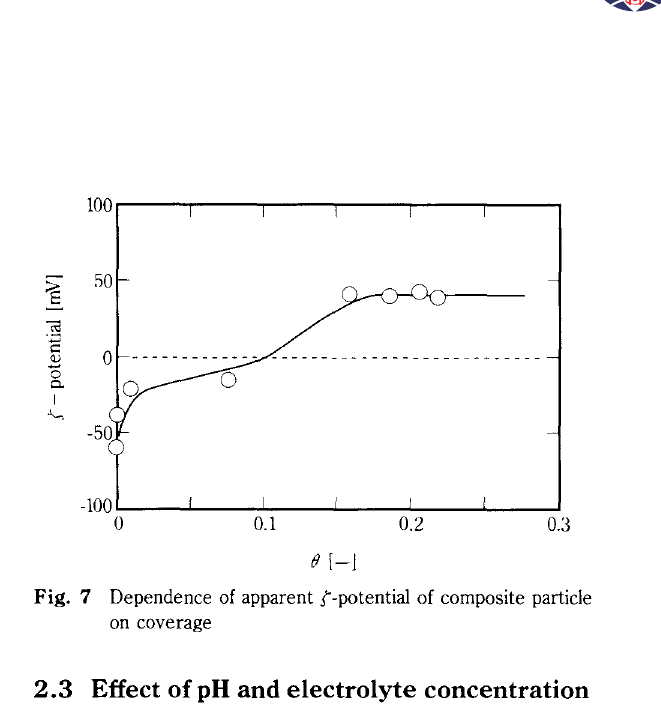
r -potential of composite particle